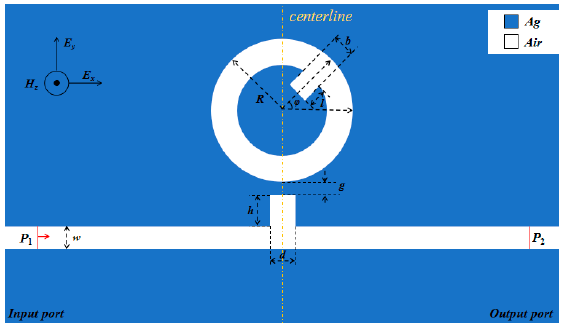
Figure 1. 2D schematic of the designed structure.